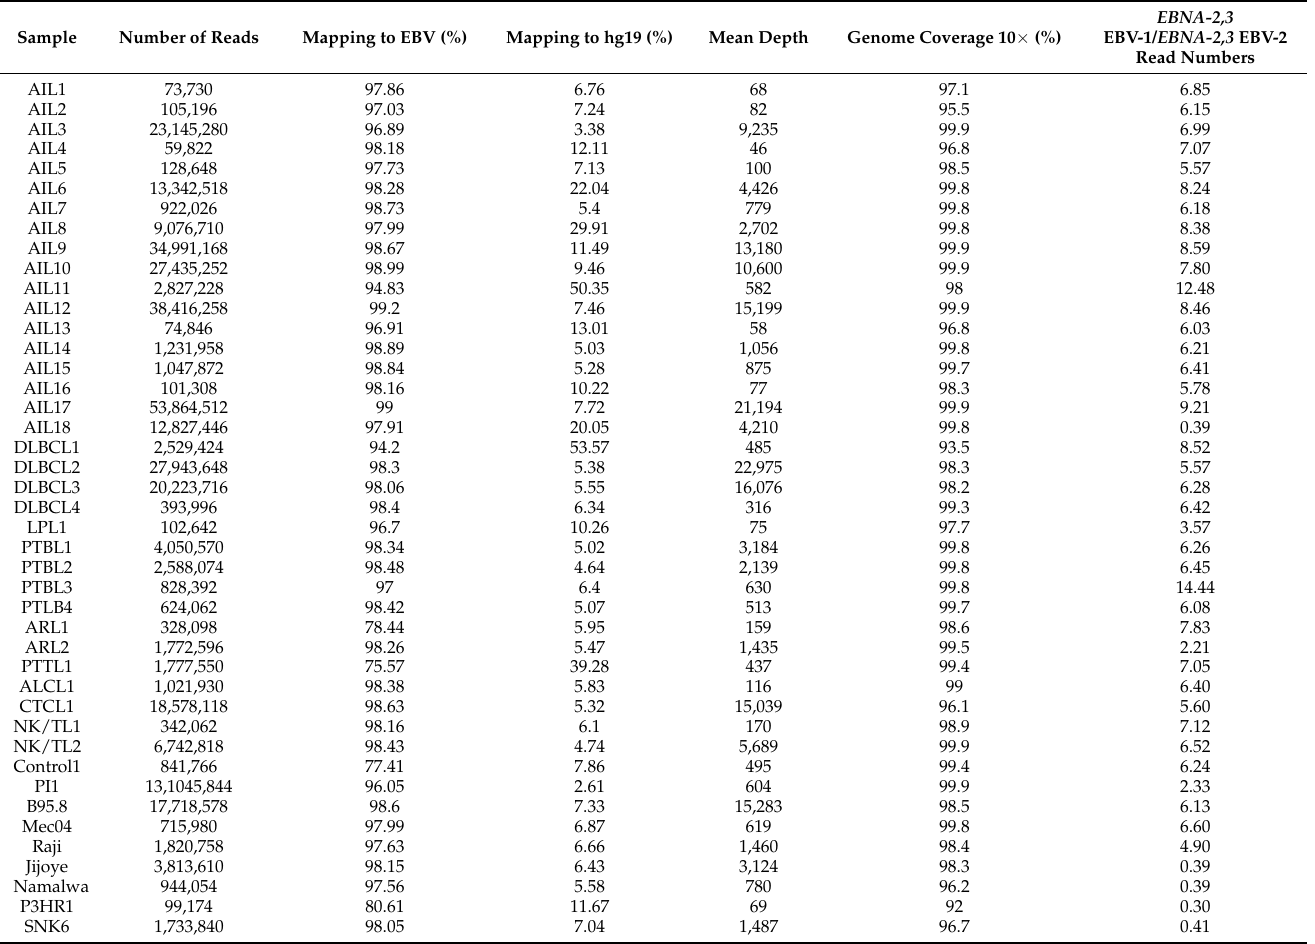
Table 2. Overall Results Obtained for Whole EBV Genome Sequencing.